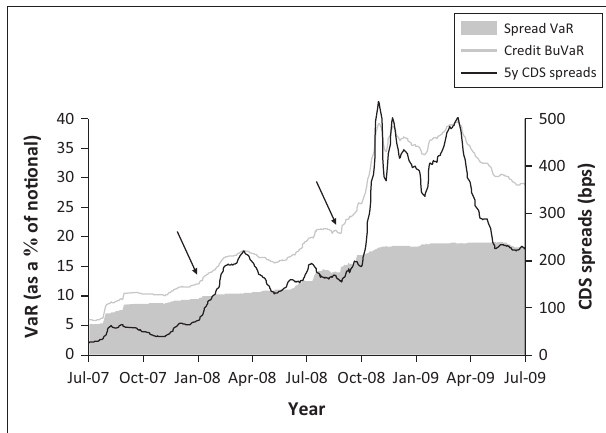
FIGURE 3: Credit risk measures on five-year credit default swap spreads using standard deviation as a measure of volatility in the months preceding the credit crisis. Arrows indicate focus regions.